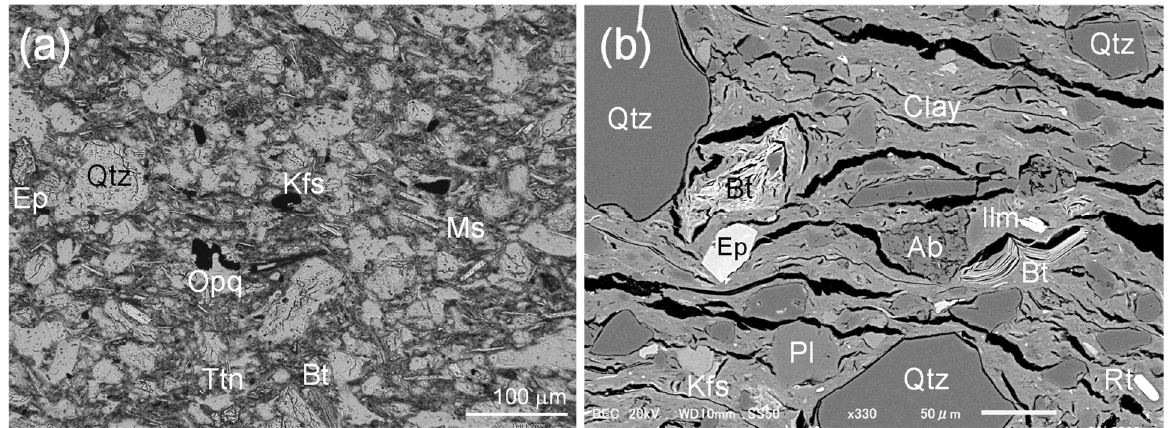
Figure 4. ( a ) Photomicrograph of thin section for pottery sample (SVL24, plane-polarized light). Abbreviations: Qtz— quartz; Ep—epidote; Kfs—potassium feldspar; Ms—muscovite; Opq—opaque mineral (ilmenite); Ttn—titanite; Bt—bio- tite. ( b ) SEM image of pottery sample (SVL12). Abbreviations: Ilm—ilmenite; Ab—albite; Pl—plagioclase; Rt—rutile; Clay—clay minerals.